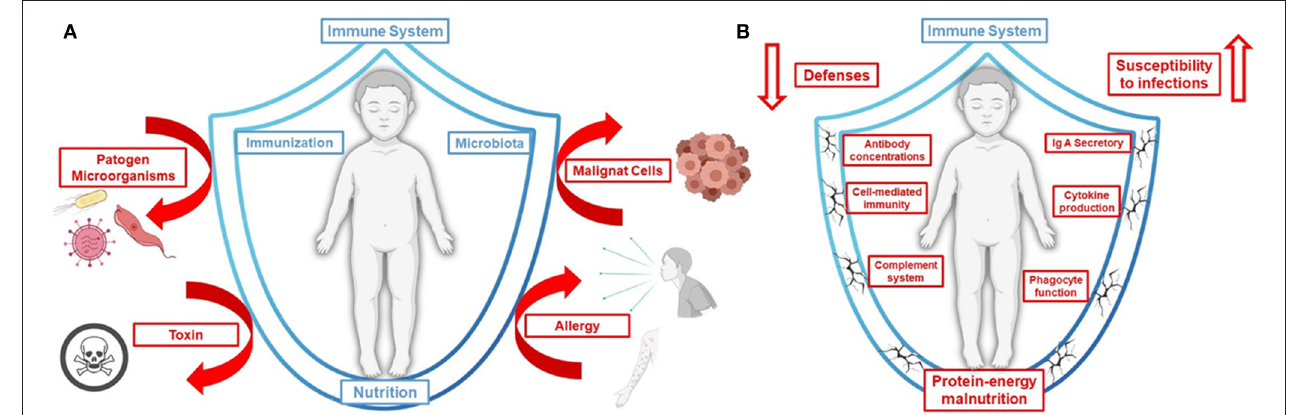
FIGURE 1 | Simple view of immune system as a shield. (A) An adequate nutritional state, a balanced microbiota and a correct immunization guarantee the strengthening of our immune defenses. (B) Protein-energy malnutrition is associated with immune dysfunction and an increase of susceptibility to infectious diseases. In turn, immune responses to infectious diseases enhance nutrient requirements, reduce appetite, and impede the absorption of nutrients creating and perpetuating a vicious cycle (Figure created with